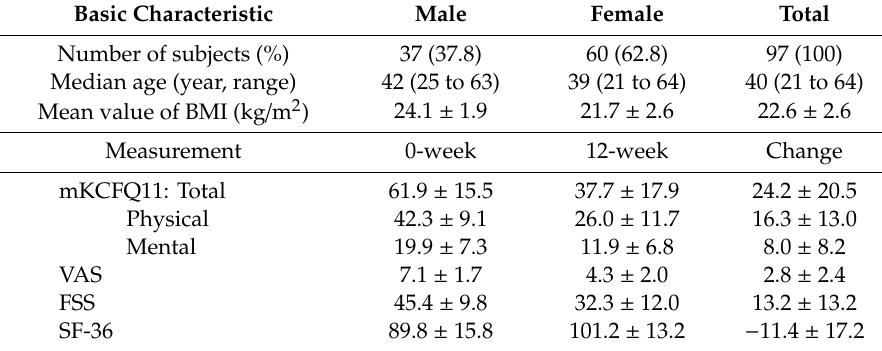
Table 4. Characteristics of the subjects and